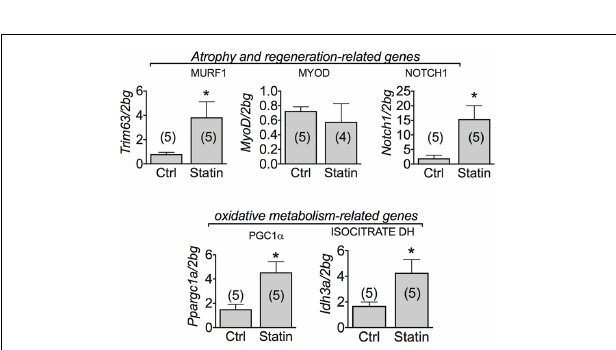
FIGURE 5 | Real-time PCR analysis of mRNA expression level of genes involved in muscle atrophy and oxidative-metabolism related genes in VL muscle biopsies of patients in therapy with statin showing sign of myopathy. Histograms show quantification of transcript levels for MuRF1, MyoD, Notch1, PGC1 α and IDH normalized by the beta-2 microglobulin gene. In each graph, the bars represent the mean values ± SEM in myopathic subjects (Statin) compared with those of untreated subjects (Ctrl) from the number of subjects indicated in brackets. ∗ Significantly different with respect to the own control ( P < 0.05 or less) by Student’s t